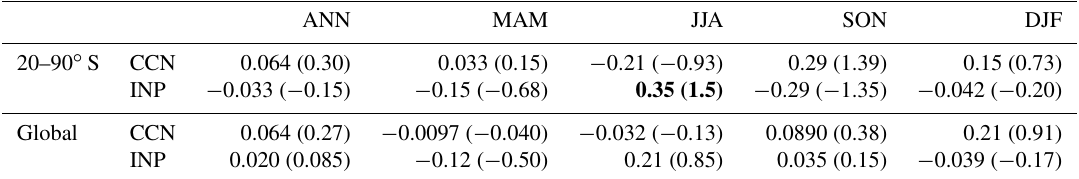
Table 8. CCN and INP effect of MOA on LWCF; the values in the table are the mean change and relative change (%). The CCN effect is cal- culated between the CTL and B14_D15 experiments, and the INP effect is calculated between the B14_D15 and B14D15_M18 experiments, with the bold font indicating the maximum